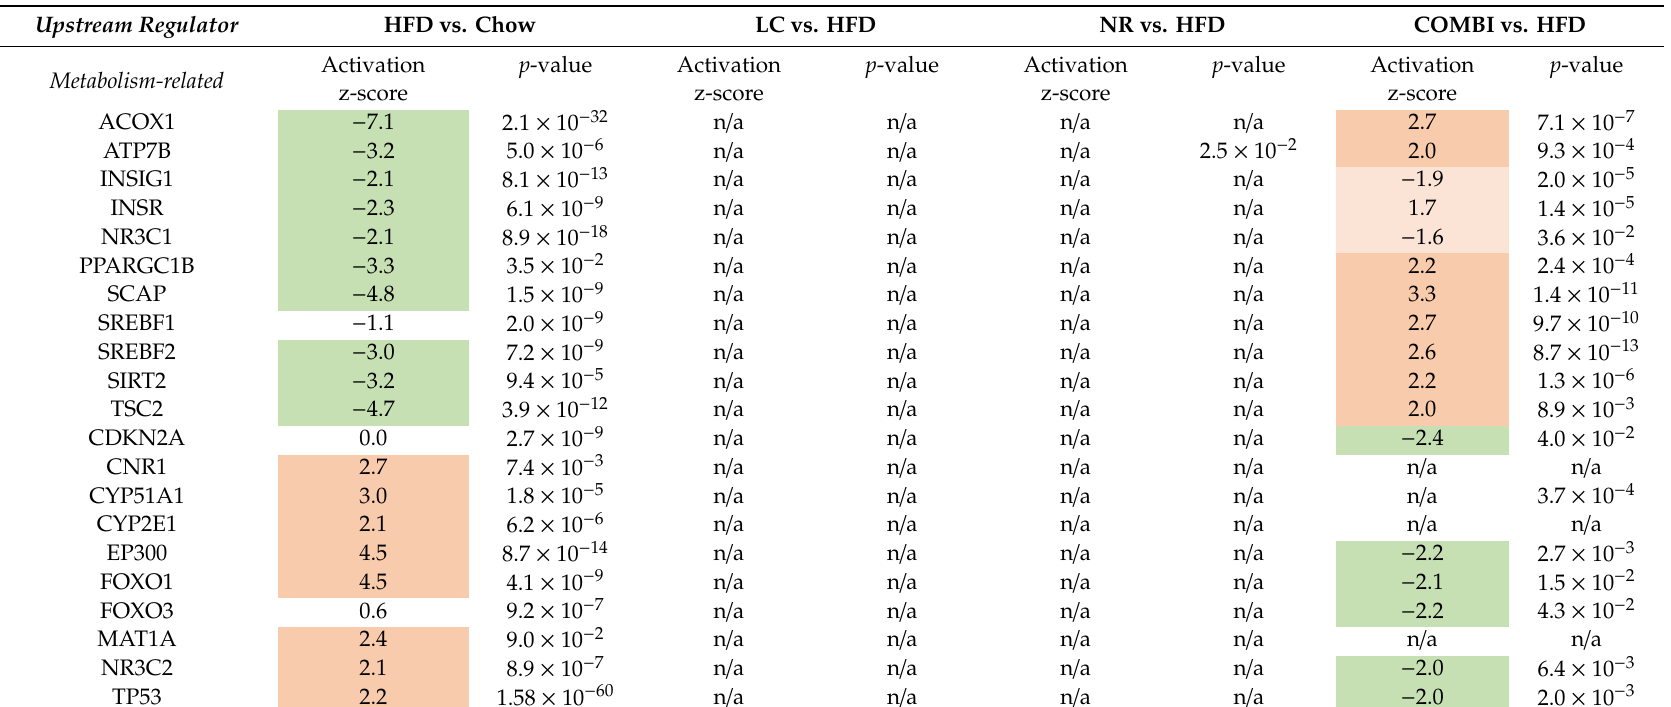
Table 3. Upstream regulator analysis based on hepatic gene expression of metabolism related